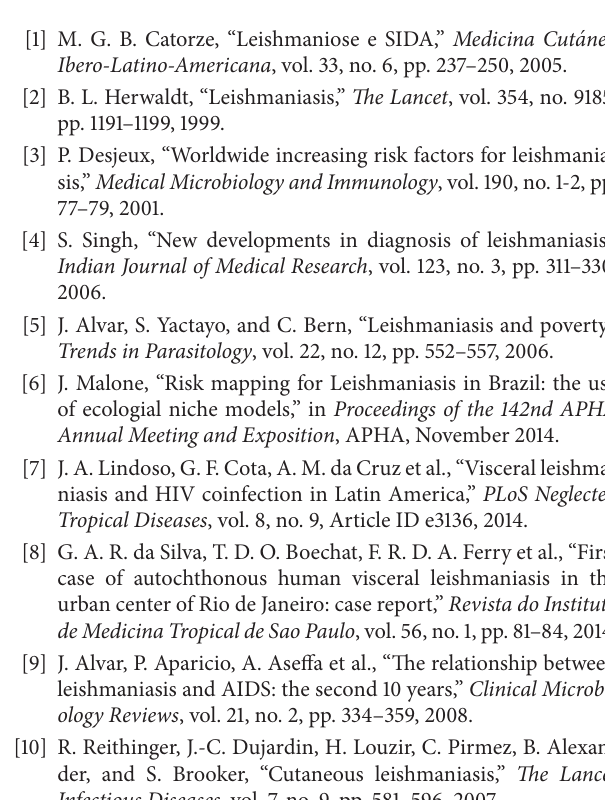
after 2 to 3 years. PKDL has also been reported to develop even 10 years after VL treatment